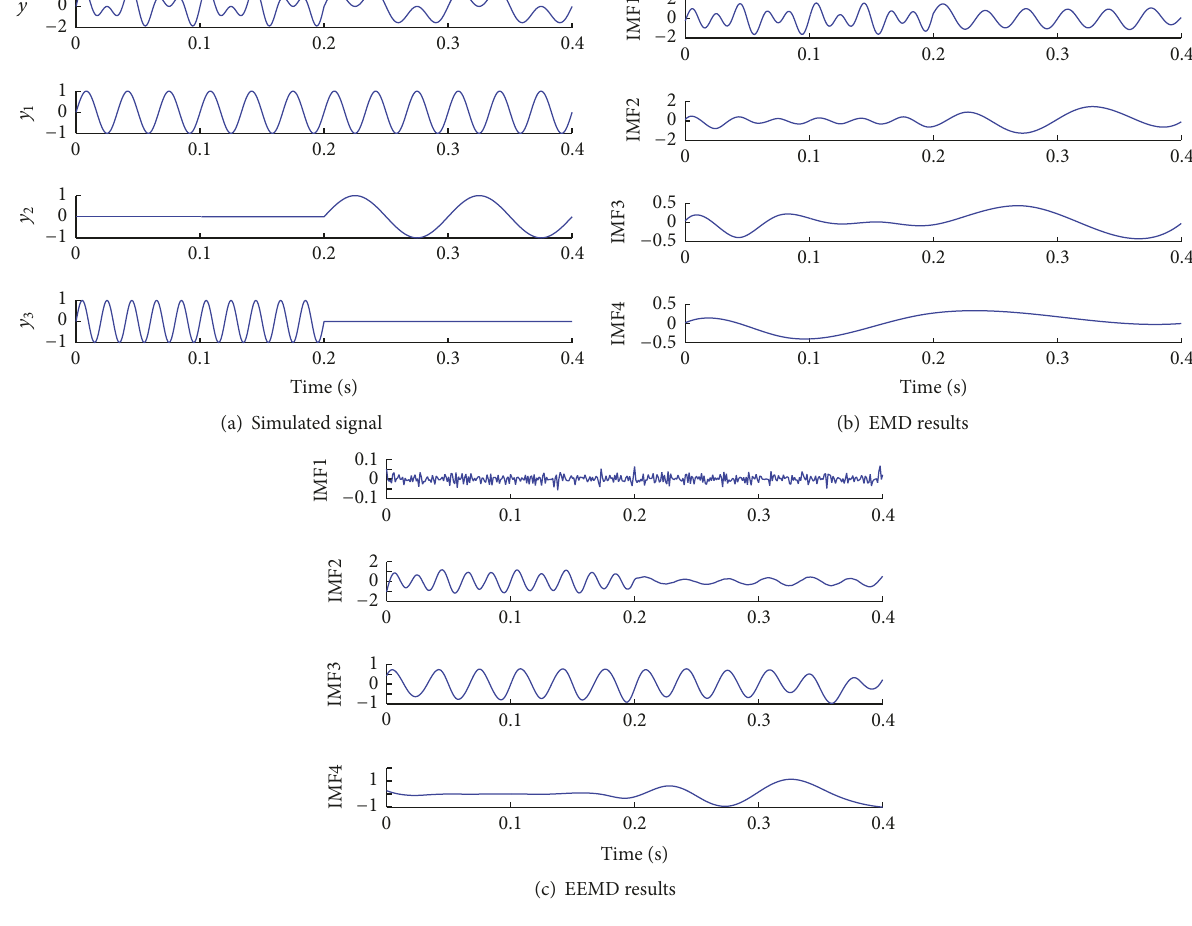
Figure 1: Comparison results of EMD and EEMD.